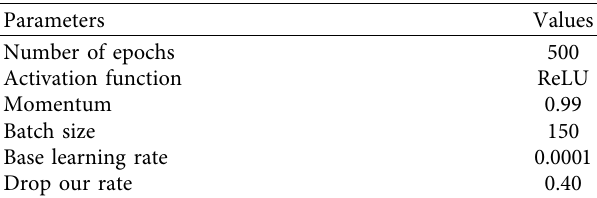
Table 4: Deep CNN parameters’